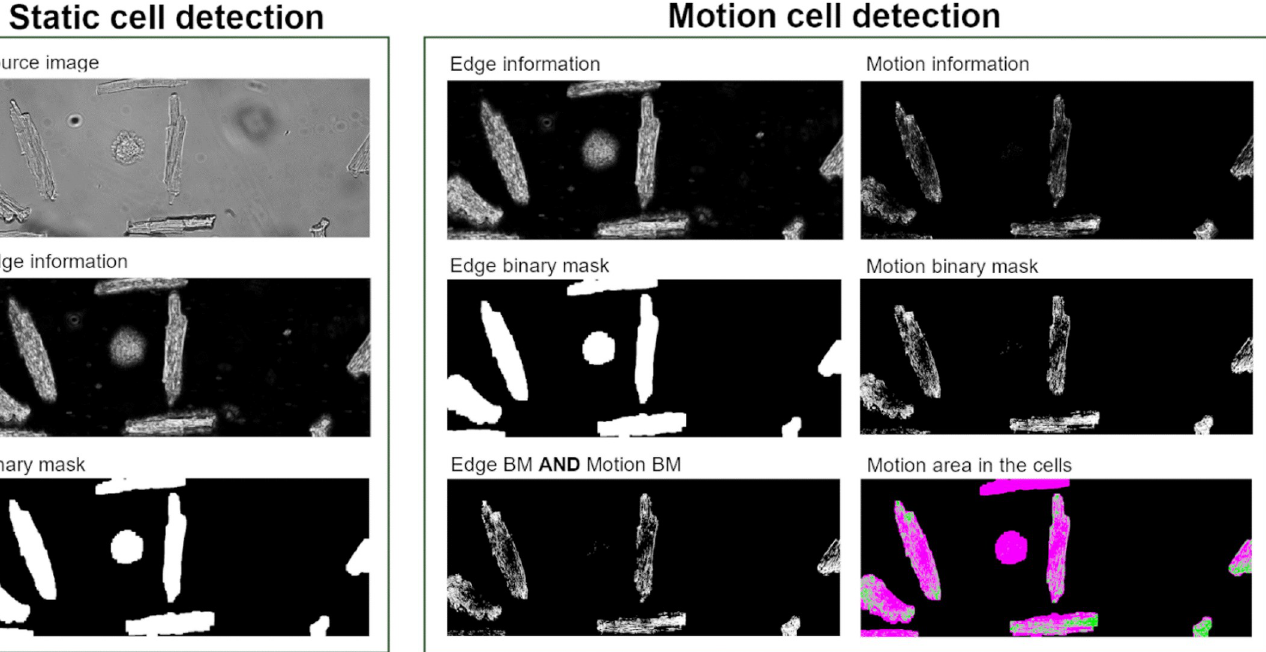
Fig 3. Pipeline of static and motion cell finding. Static cell detection only finds cells within a predefined minimum/maximum area and width and height ratio. Motion cell detection finds cells with sufficient motion information in it.